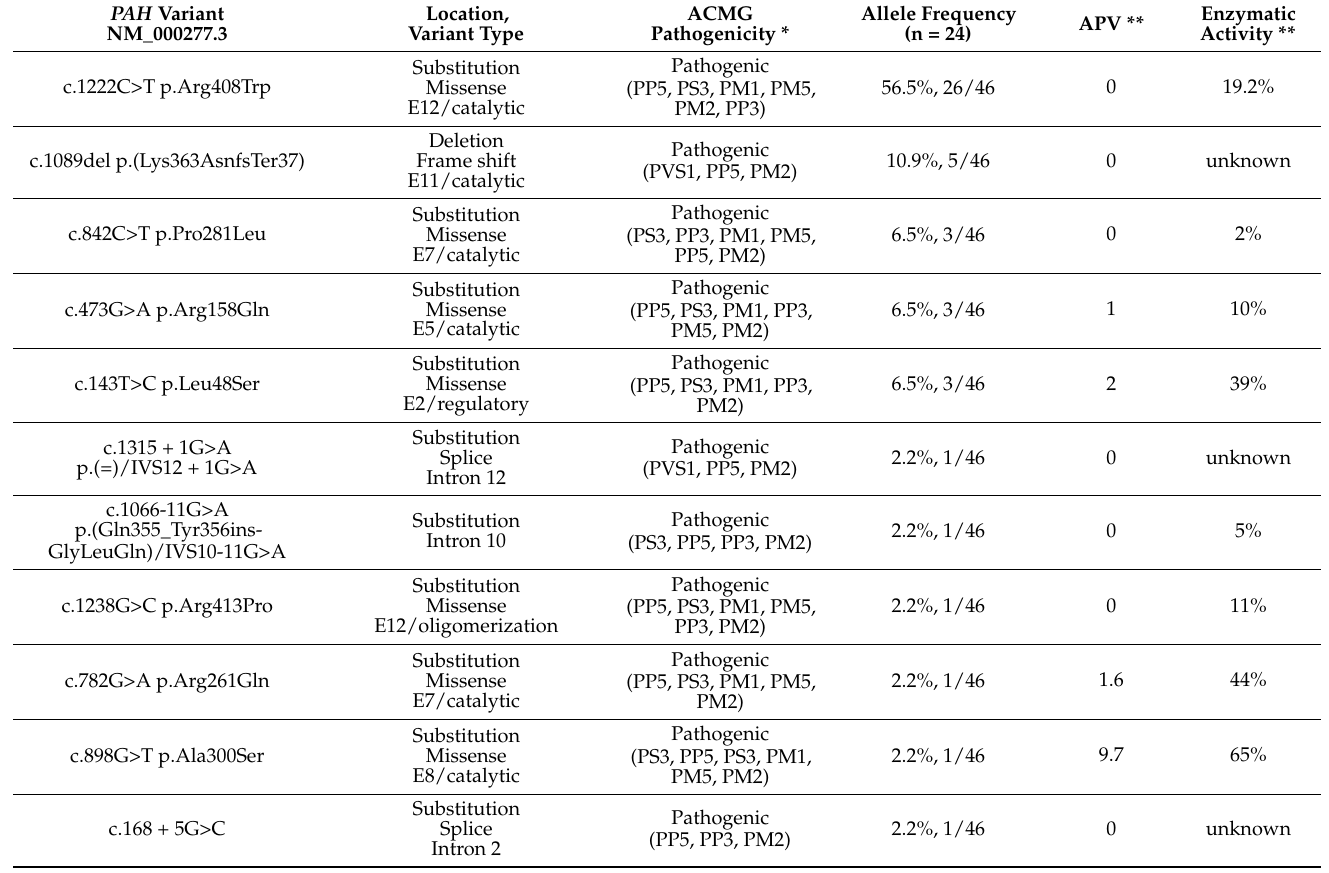
Table 2. Mutation spectrum of the studied